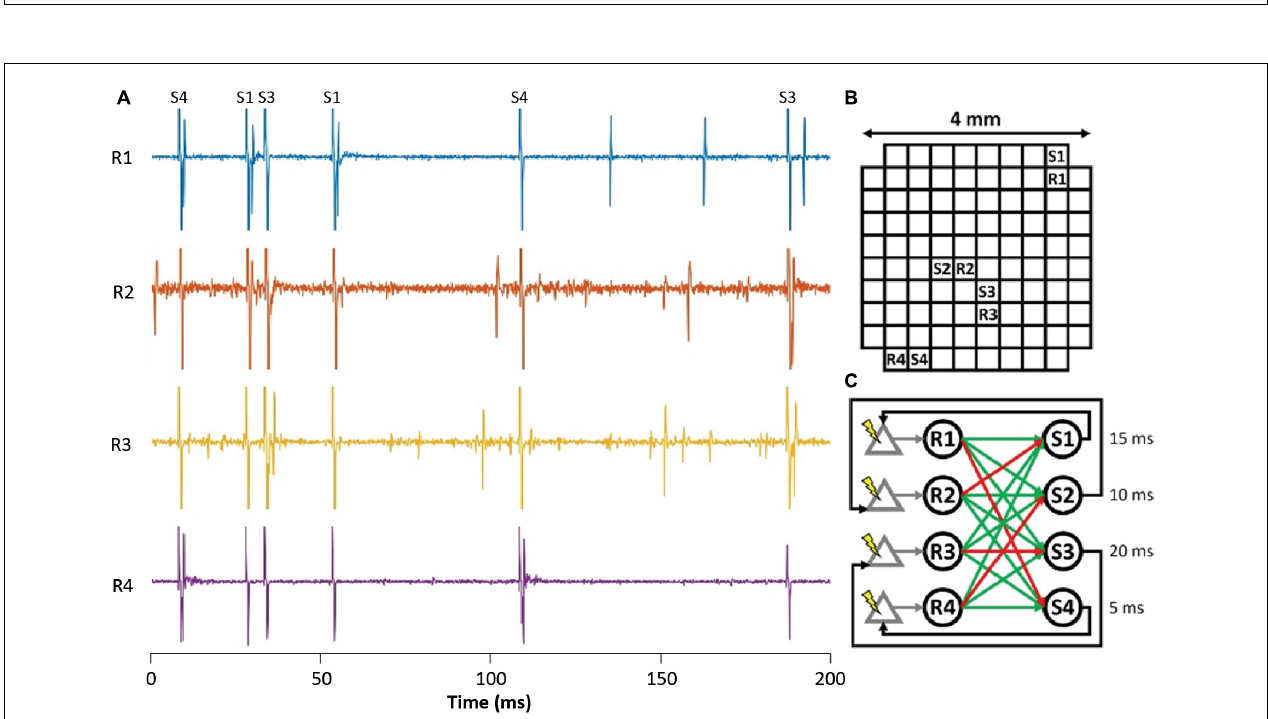
FIGURE 11 | Implementation of a simple closed-loop BCI via an ANN. (A) Spike activity of simultaneously recorded input neurons (R1-R4) during stimuli delivered at outputs (S1-S4). Labels at top identify stimulus channels producing corresponding stimulus artifacts. (B) Location of recording and stimulating sites on Utah array. (C) Connectivity of spiking SNN showing excitatory (green) and inhibitory (red) connections from inputs (R1–R4) to outputs (S1–S4). Numbers are delays between output spikes and stimuli.